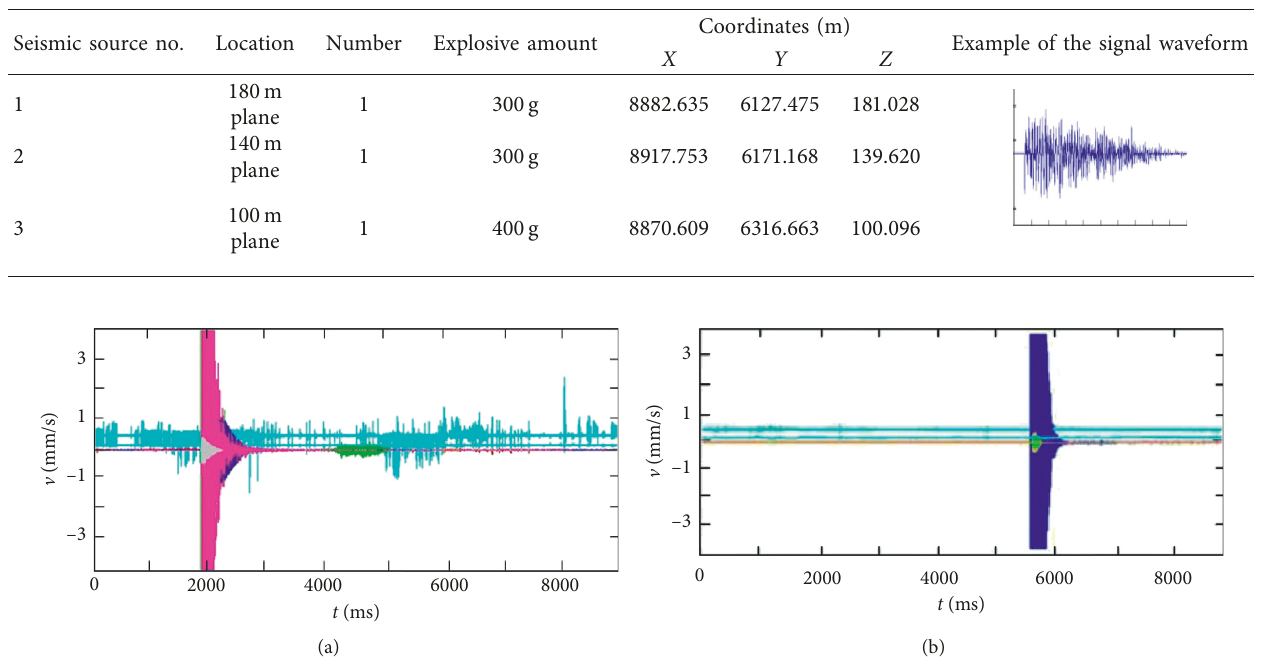
Table 2: Microblasting source.